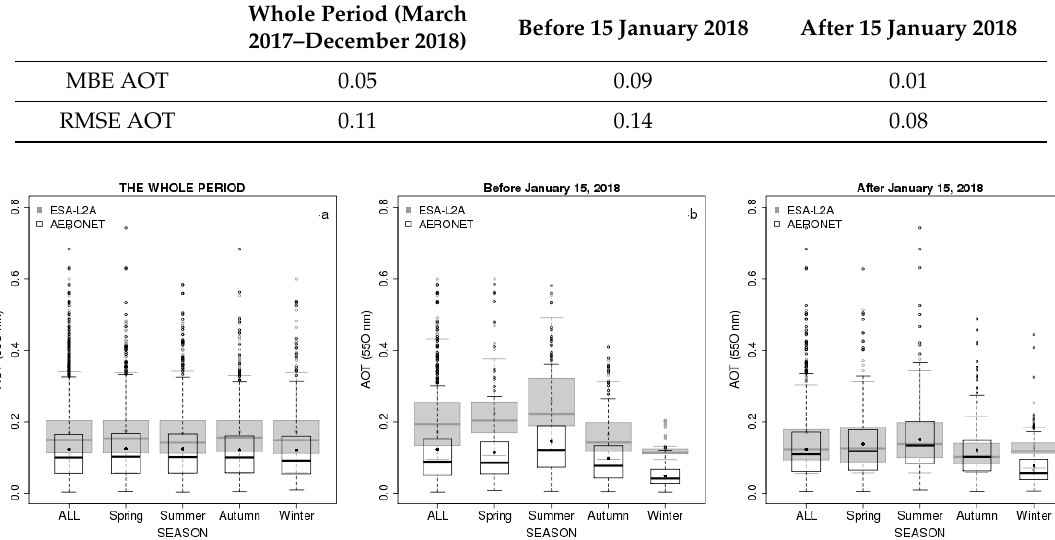
Table 3. Mean bias error (MBE) and root mean square error (RMSE) AOT values for the whole period, the period before 15 January, 2018 and the period after 15 January, 2018.